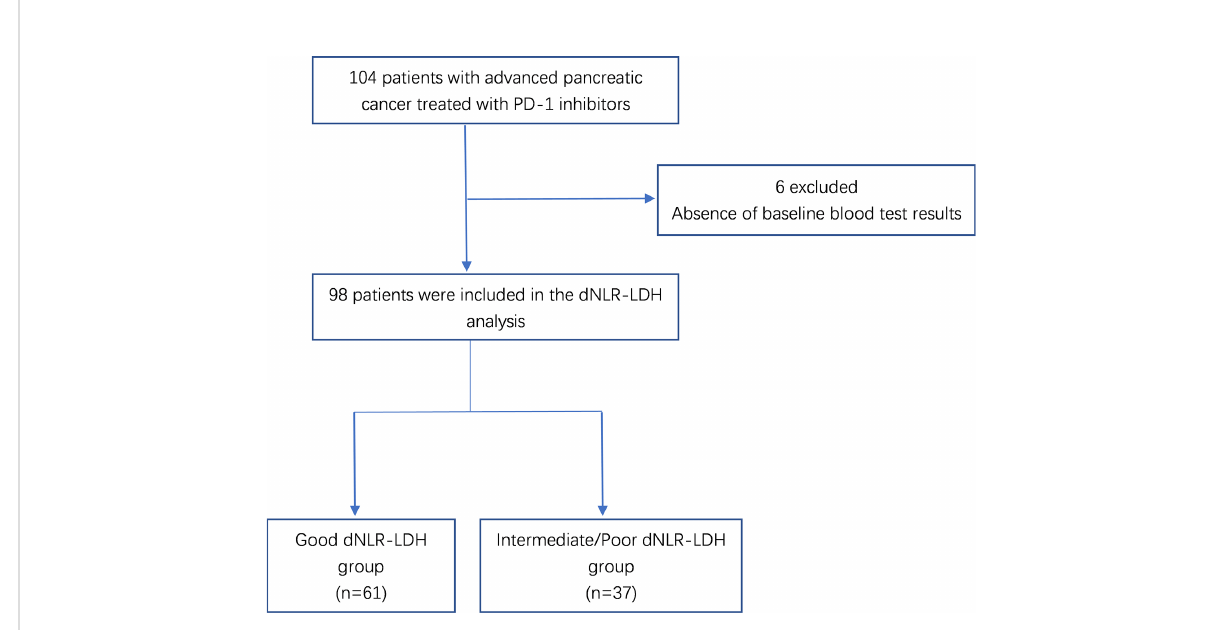
FIGURE 1 Flowchart of patient